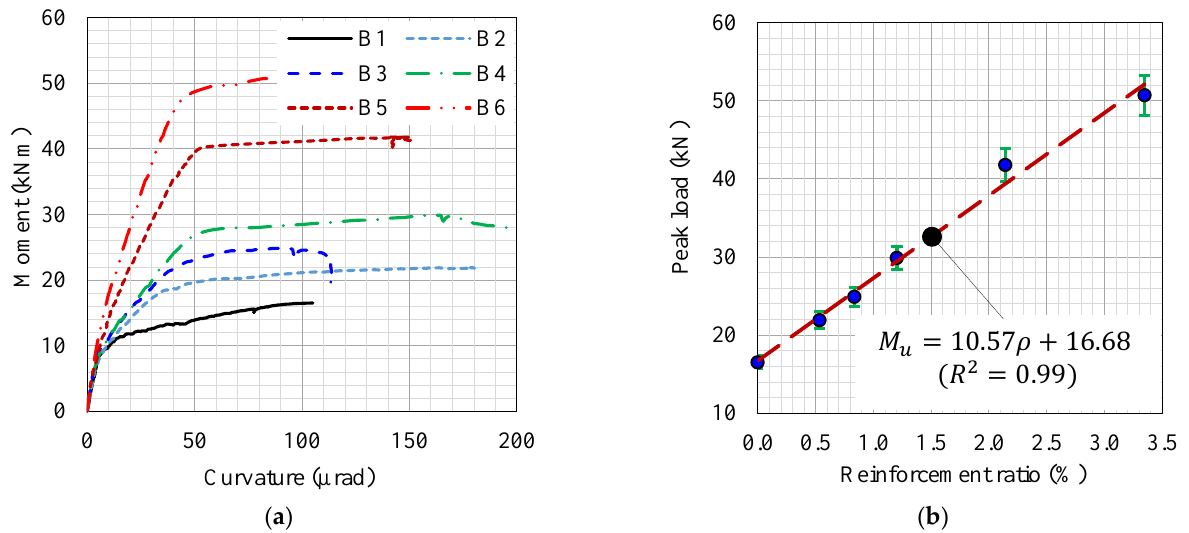
( f ) Figure 9. Moment – curvature responses of ( a ) B1, ( b ) B2, ( c ) B3, ( d ) B4, ( e ) B5, and ( f ) B6. Figure 10a depicts a representative moment – curvature response for B1 – B6. This fig-